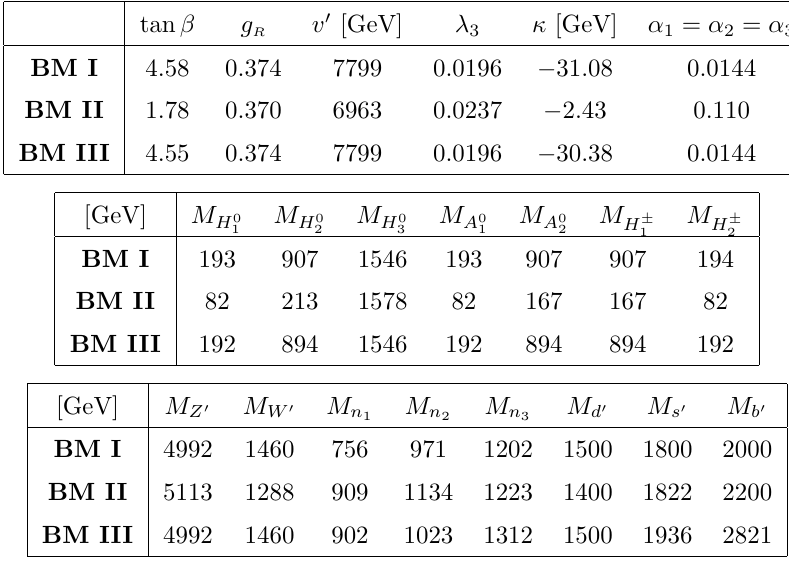
Table 3 . Values of the free ALRSM parameters de(cid:12)ning our three benchmark scenarios BM I , BM II and BM III (upper panel) and resulting mass spectrum (middle and lower panels). All masses are given in